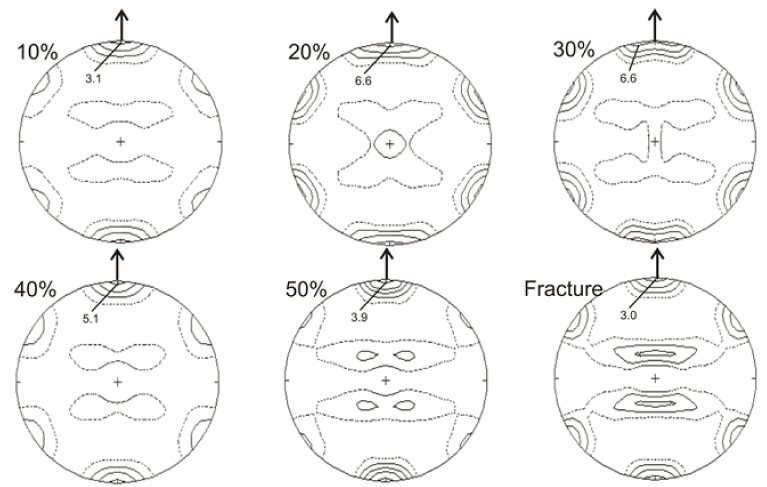
Figure 7. Calculated pole figure for ε -martensite {0002} after selected deformation degrees.